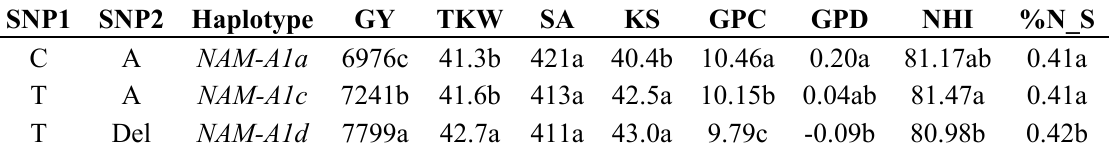
Table 2. Mean agronomic values for the two NAM-A1 single nucleotide polymorphism (SNP) genotyped on 196 (16 NAM-A1a ; 37 NAM-A1c ; 143 NAM-A1d ) European elite